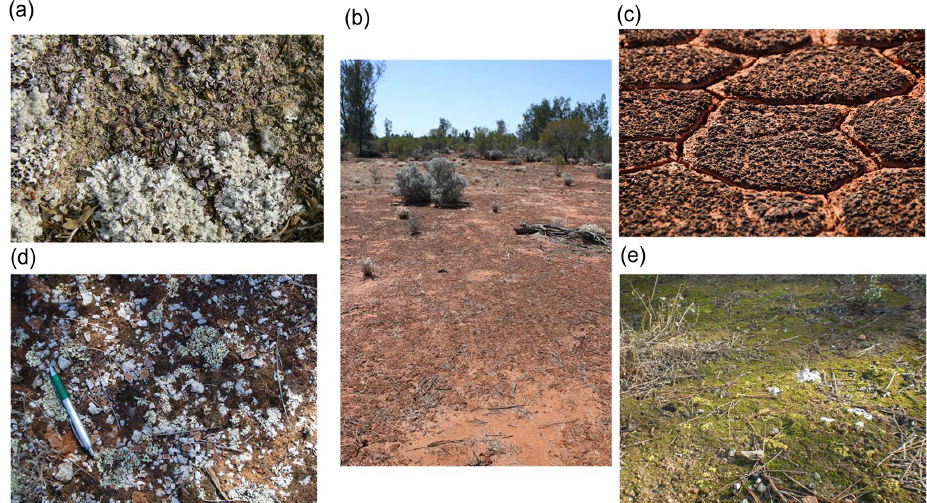
Figure 10. Examples of bare ground areas with lichen-dominated cyanobacterial biocrusts (a) , cyanobacteria-dominated biocrusts (b, c) , cyanobacteria/lichen/moss-dominated biocrusts (d) and moss-dominated biocrusts (e) . Photographs by Matthew Bowker (a, c, d) , David El- dridge (b) and Fernando T. Maestre (e) .